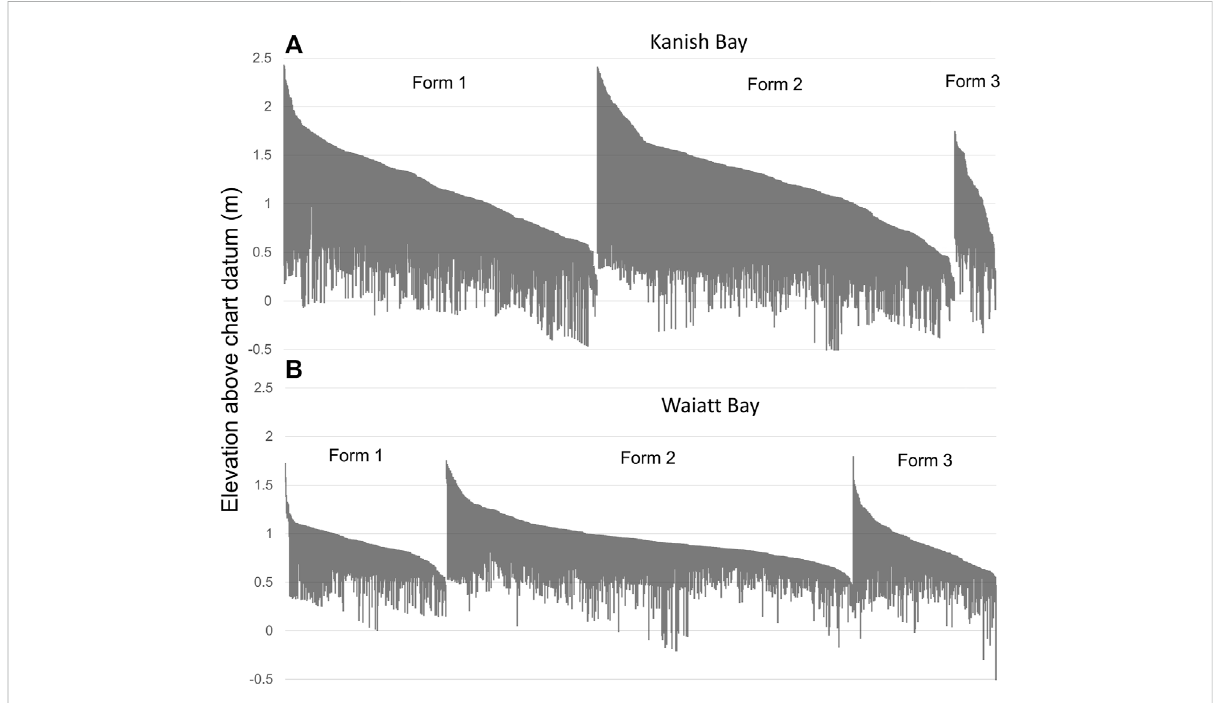
FIGURE 6 Kanish Bay (A) and Waiatt Bay (B) wall elevation samples ofForms 1, 2, and 3clam gardens arranged from highestupper wallelevation to lowest above Canadian chart datum (Lower Low Water Large Tide; LLWLT), Each grey vertical line represents an upper and lower elevation of a 5-m length of